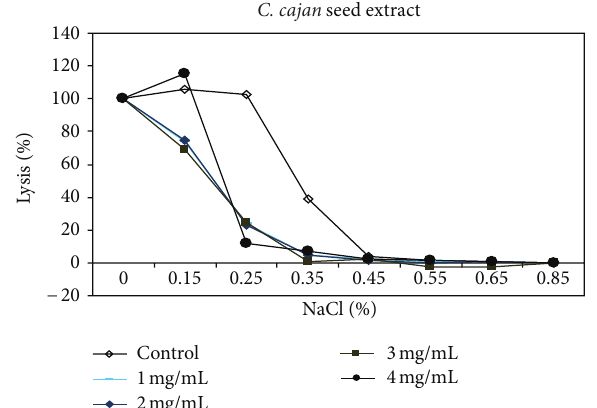
Figure3:Osmoticfragiliogramsaftersupplementationwithvarious concentrations of C. cajan seed extract.